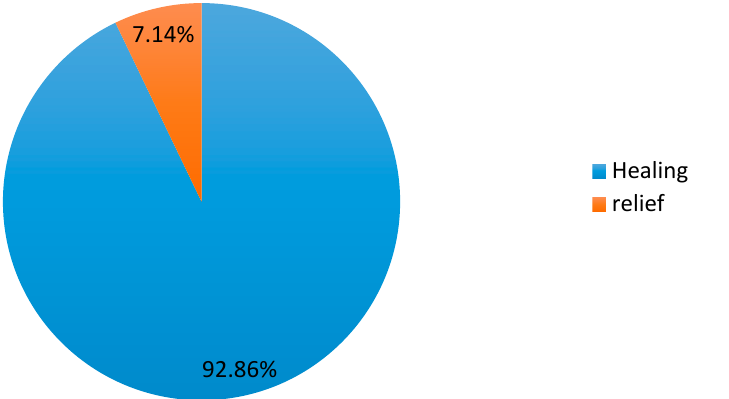
Figure 3. The opinion of herbalists on the efficacy of Salvia argentea .